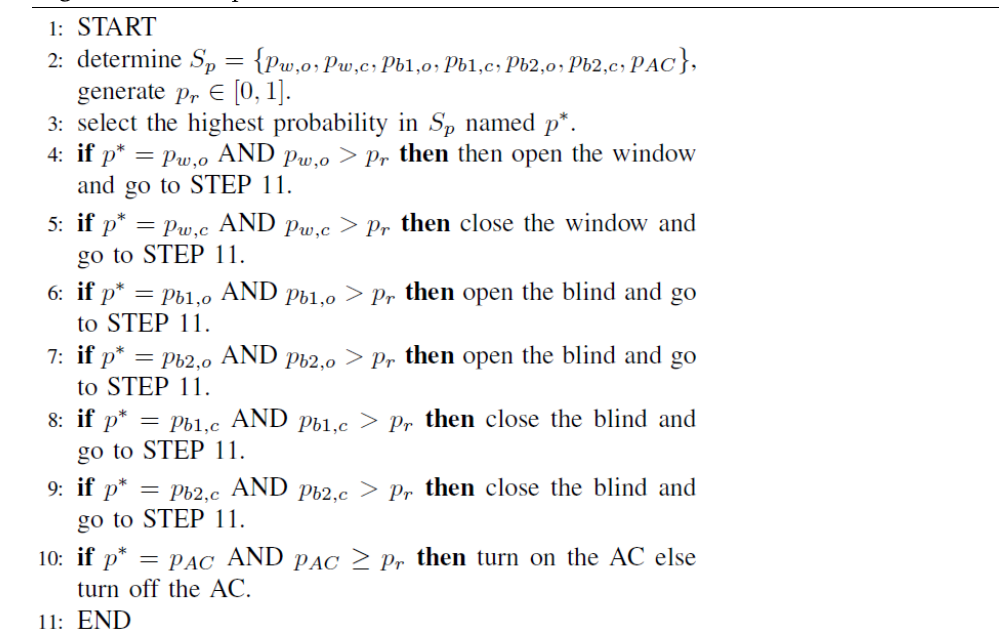
Algorithm 1 Occupant